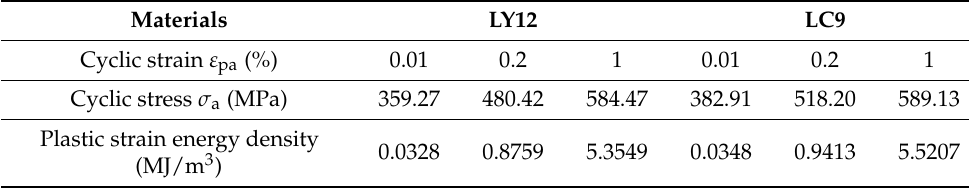
Table 5. Plastic strain energy densities of LY12 and LC9 in a single